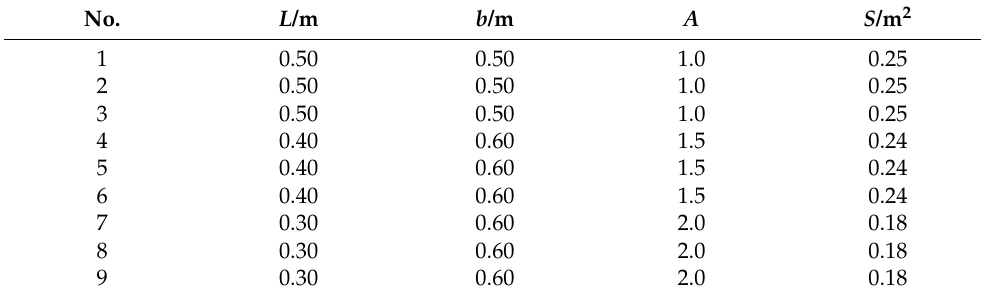
Table 3. Dimensions and structural parameters of the otter board